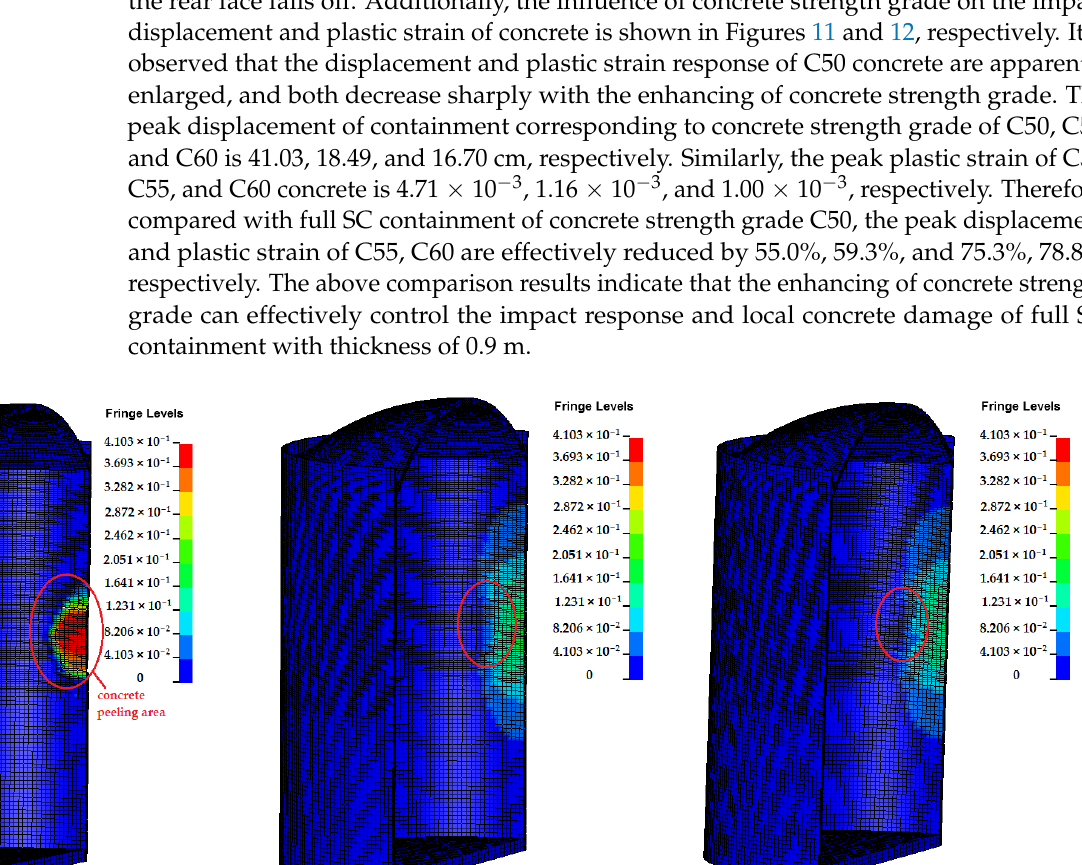
Figure 11. Max displacement time-history of containment. Figure 12. Max plastic strain time-history of concrete.